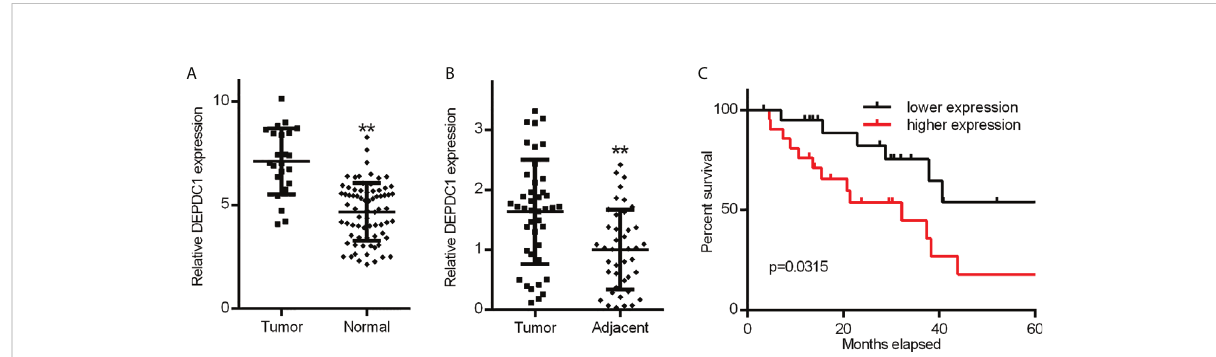
FIGURE 1 Increased OSCC tissue expression of DEPDC1. (A) Discovery in OSCC tissue samples of DEPDC1 expression via qRT-PCR by GSE31056 dataset. (normal n=73, tumor n=23). (B) DEPDC1 mRNA expression identi fi cation in OSCC tissue and neighbouring qRT-PCR samples (n = 42). (C) The general survival (O.S.) rate by Kaplan-Meier analysis is shown for OSCC patients with low or high DEPDC1 expression. (** P < 0.01). The data are presented as the mean±SD. Replicate assays were performed three times.